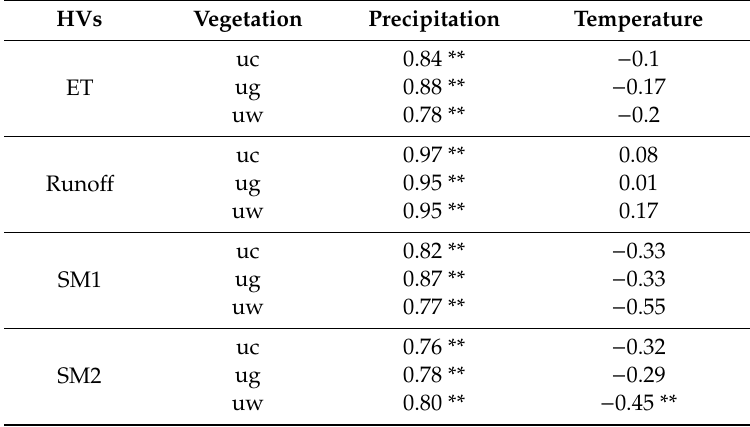
Table 2. Pearson correlation coe ffi cient between the four HVs and two key meteorological factors. HVs Vegetation